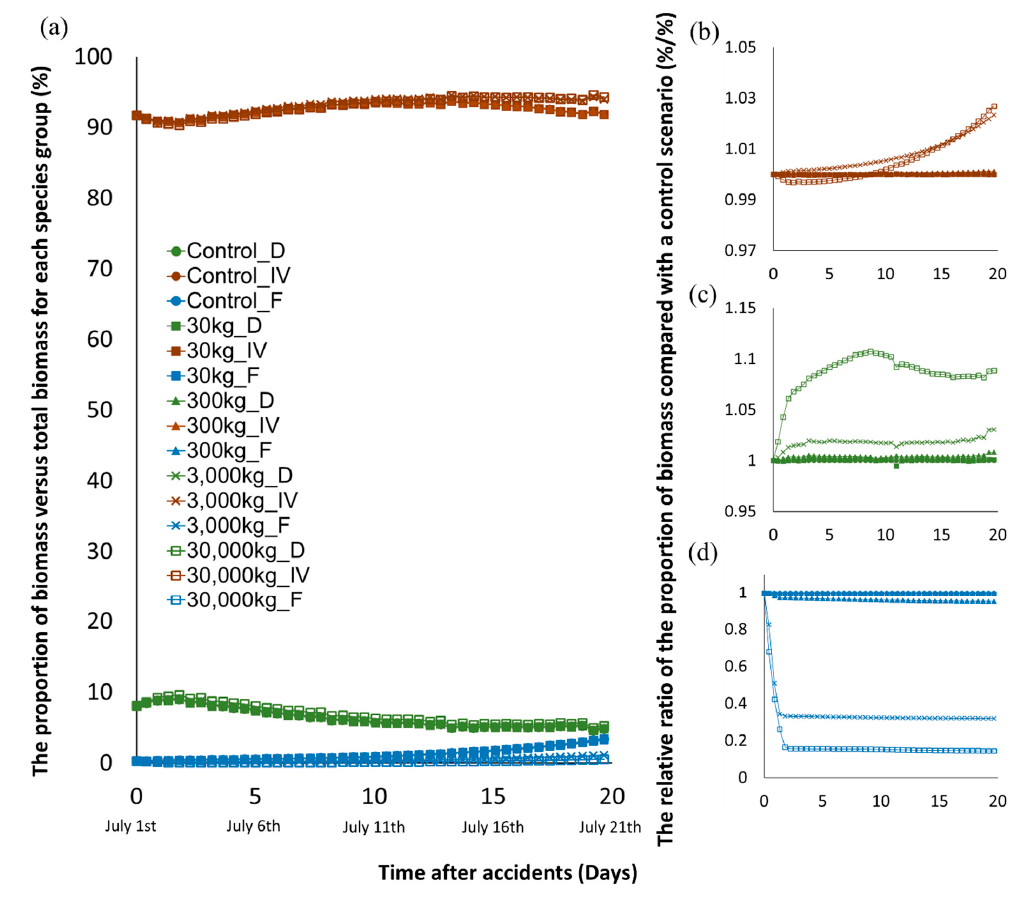
Figure 7. ( a ) The proportion of biomass of each species group versus total biomass (%) (D for diatoms, IV for invertebrates, and F for fishes) for scenarios at segment B. Additionally, the relative ratio of the proportion of biomass in the perturbed scenario versus the proportion in the control scenario (%/%) of ( b ) invertebrates group, ( c ) diatoms group, and ( d ) fishes group.